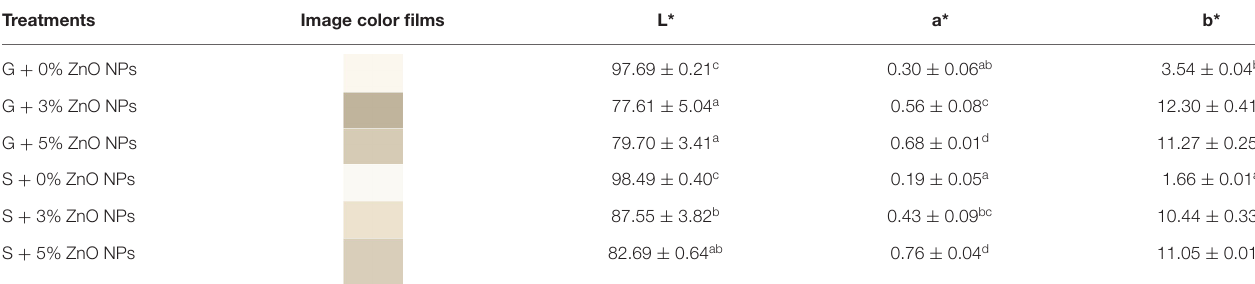
TABLE 3 | The L * , a * , and b * value of bionanocomposite films. Treatments